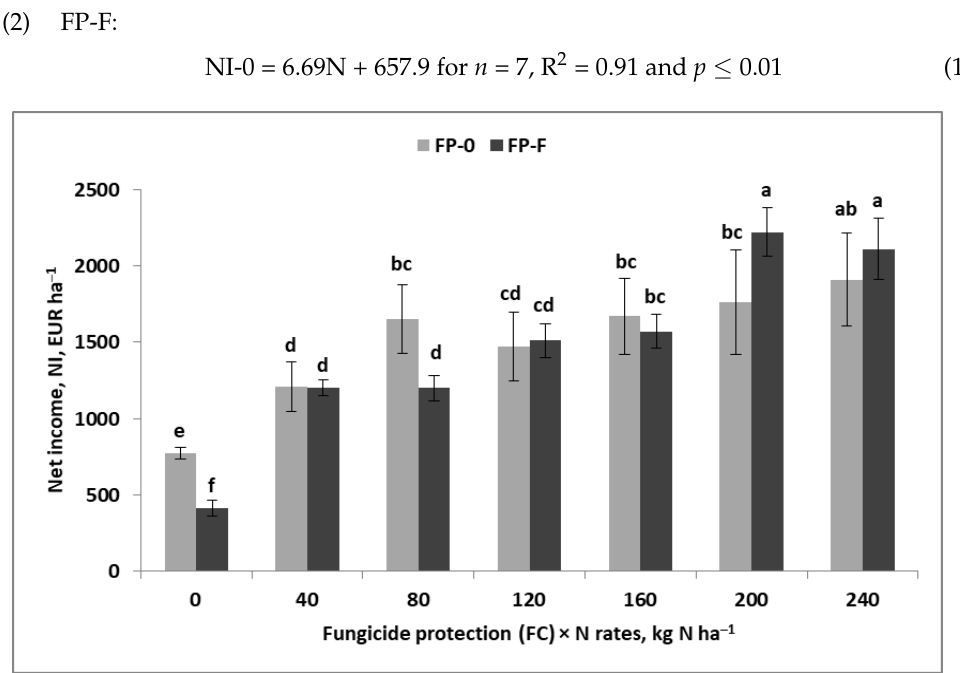
Figure 8. Effect of winter wheat protection with fungicides and rates of fertiliser nitrogen on net income. Similar letters in the column means a lack of significant differences using Tukey’s test; the vertical bar in the column refers to the standard error of the mean.